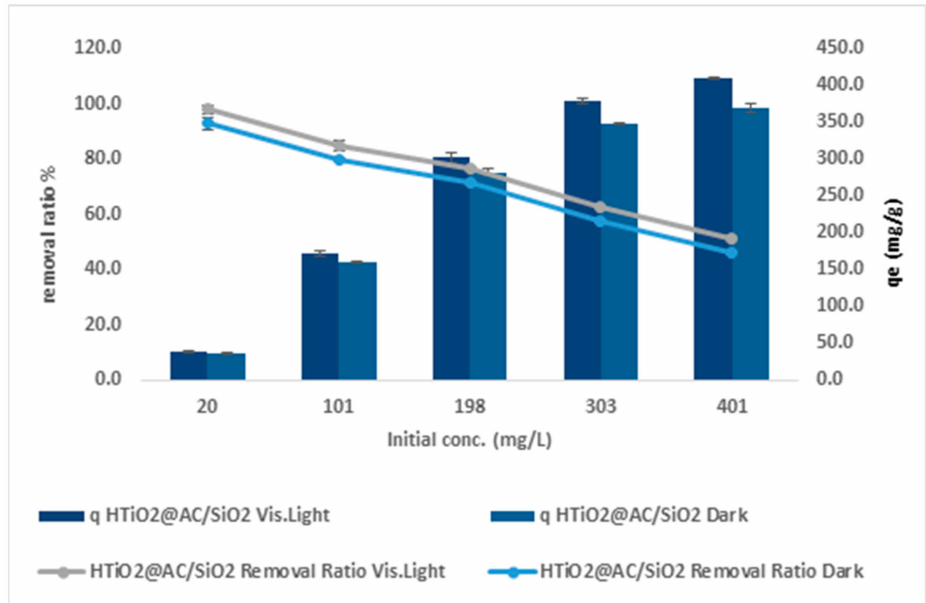
Figure 8. Chlorpyrifos concentration